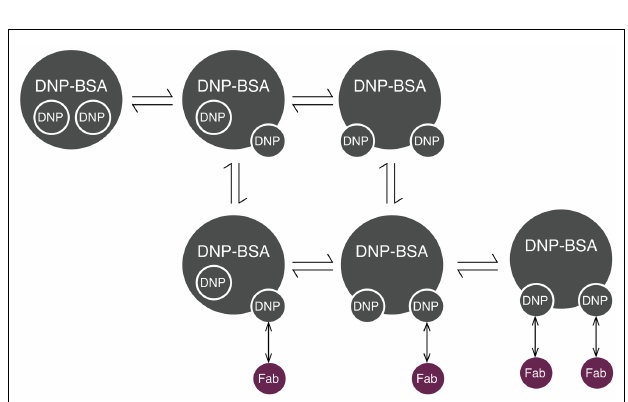
FIGURE 1 |An overview of intracellular signaling interactions included in the model/library for Fc ε RI signaling . Rules are included in the library for the interactions depicted here. Proteins are represented as circles that are color-coded according to their function, as indicated in the legend. Standard UniProt names are used, and we note that Grap2 is commonly known as Gads, Lcp2 is commonly known as Slp76, and Inpp5d is commonly known as Ship1.The legend also indicates the arrows that are used to represent